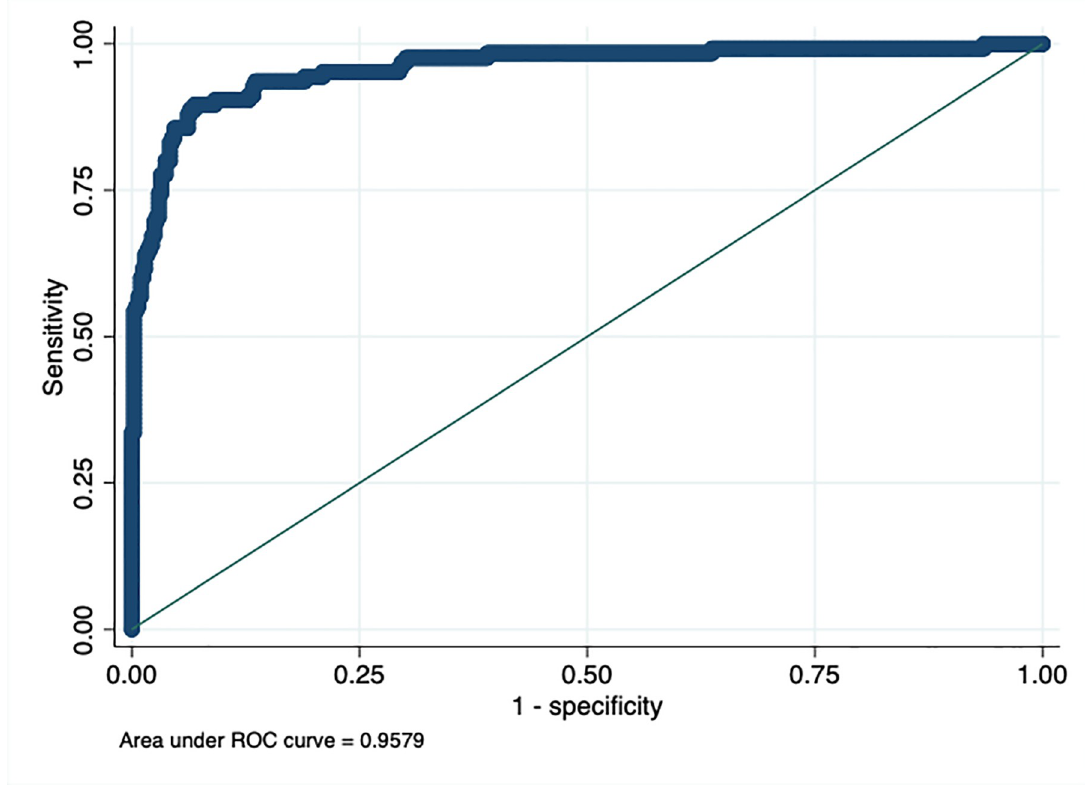
Fig 1. Receiver operating curve (ROC) multivariate logistic regression model of risk